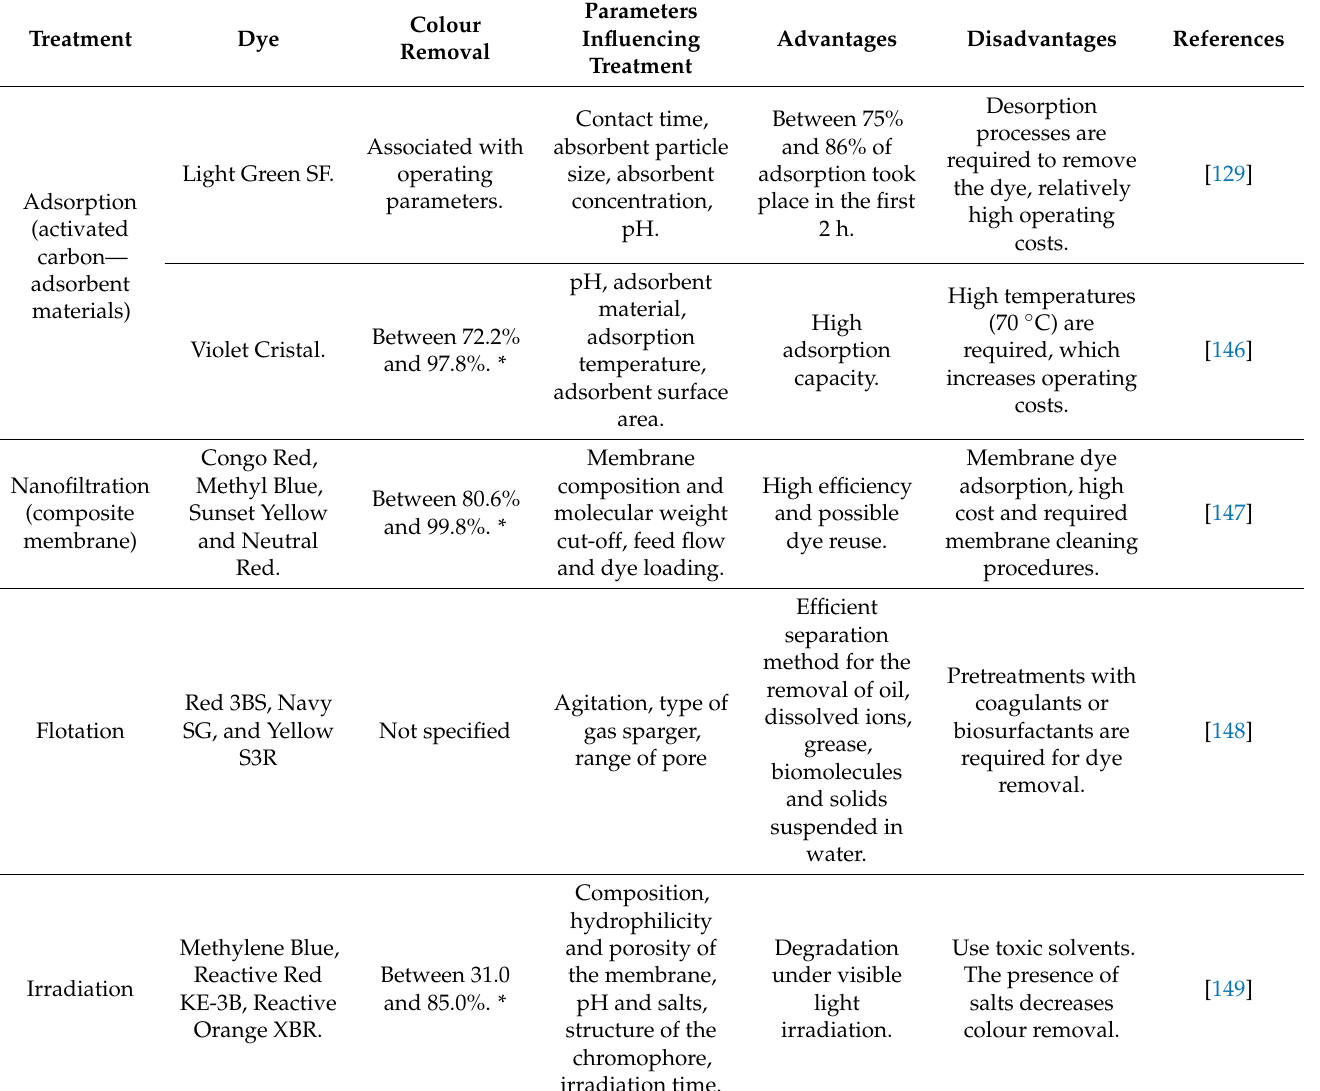
Table 4. Some physical treatments used in the removal of